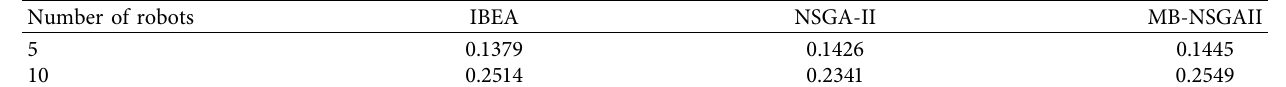
Table 6: Experimental results of HV when robots perform 100 tasks.